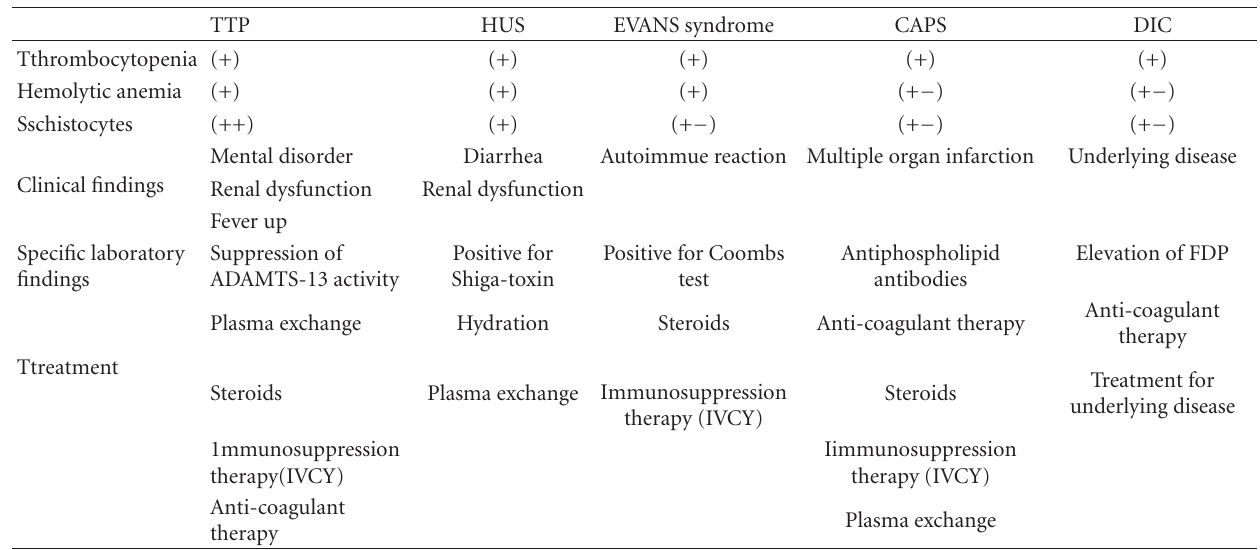
Table 2: Di ff erential diagnosis of hemolytic anemia with thrombocytopenia. The diseases possibly resembling TTP are summarized in Table 1. TTP: thrombotic thrombocytopenic purpura, HUS: hemolytic-uremic syndrome, CAPS: catastrophic anti-phopholipid antibody syndrome, DIC: disseminating intravascular